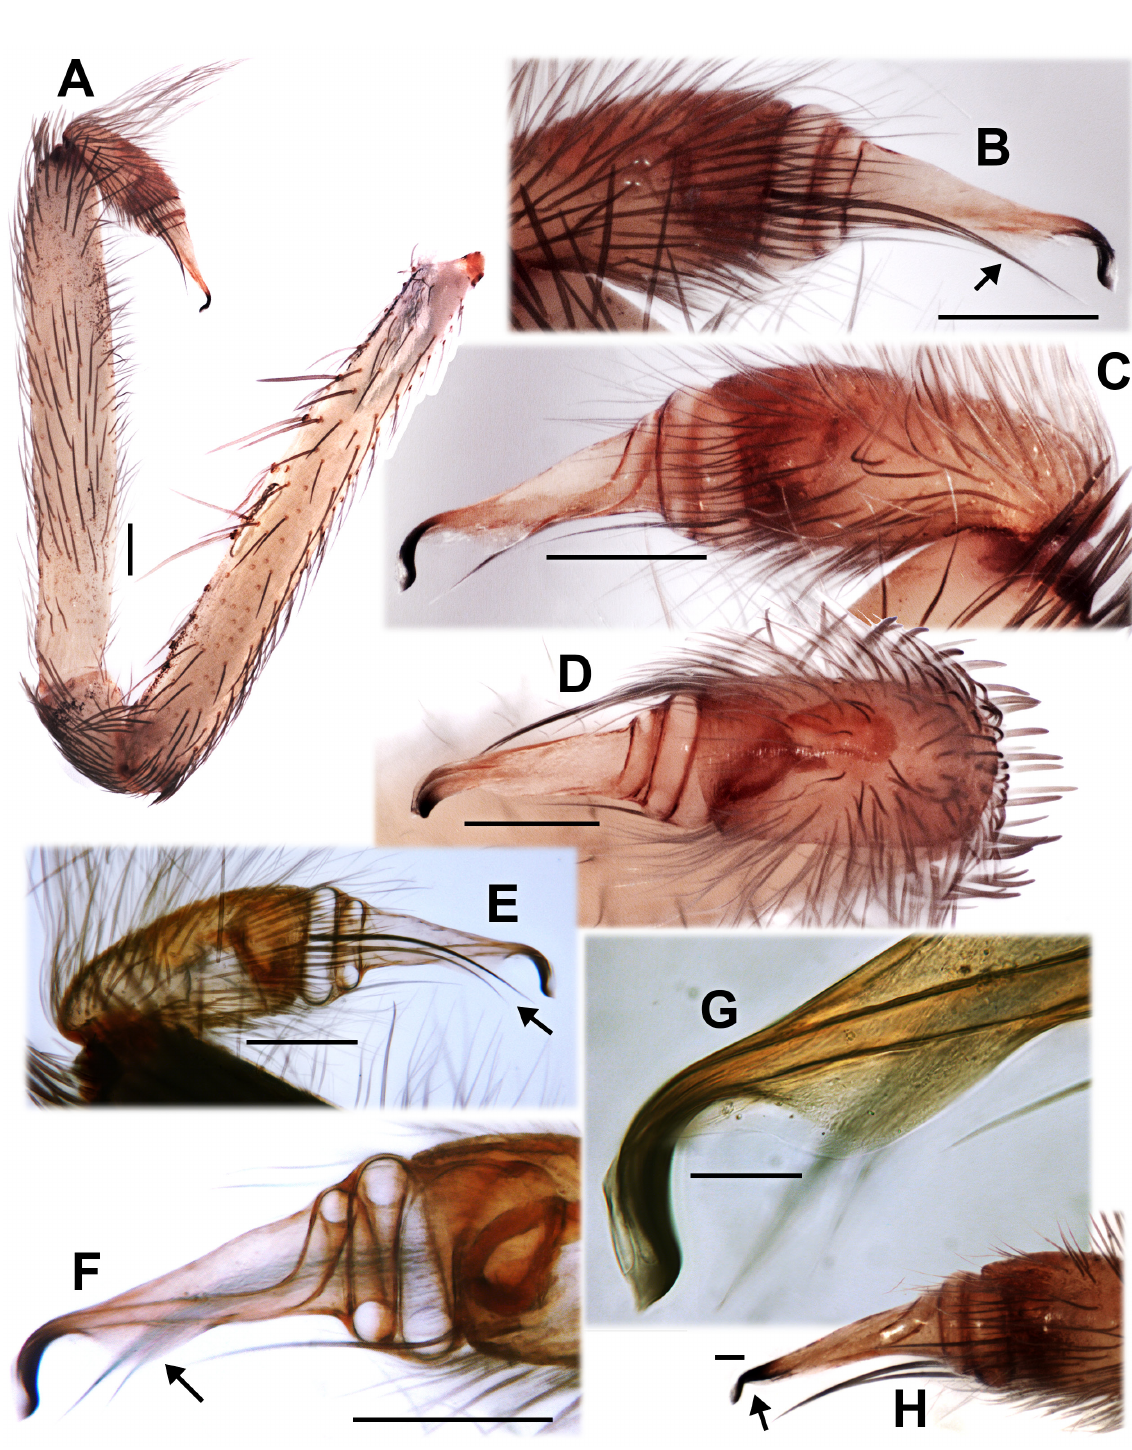
Fig. 8. A–G . Filistata betarif sp. nov., holotype, ♂ (HUJ -INVAr 21058), left pedipalp. A–B, E . Prolateral view. Arrow points to prolateral strong setae in cymbium. C, F–G . Retrolateral view. Arrow points to embolic keel. D . Dorsal view. — H . Filistata insidiatrix (Forsskål, 1775) (MACN-Ar 39461), bulb, retrolateral view. Arrow points to embolic keel. Scale bars: A–F = 0.2 mm; G–H =